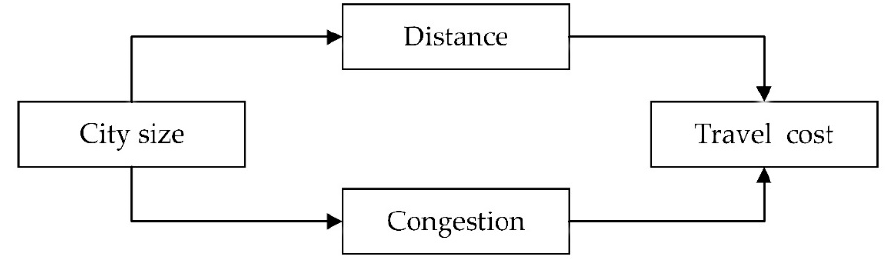
Figure 1. The influence pathways of city size on travel costs.